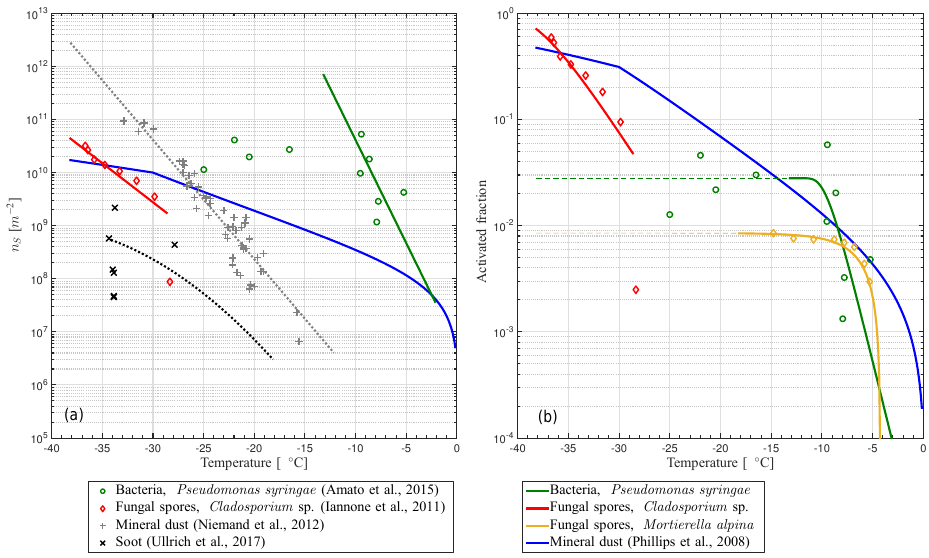
Figure 1. (a) INAS density n S and (b) ice-active fraction f IN versus temperature T for PB-INPs ( Pseudomonas syringae bacteria, Cladospo- rium sp., and Mortierella alpina fungal spores; r N of Table 1 used here) as well as mineral dust (Phillips et al., 2008, assuming a particle size of r N = 3 . 45 × 10 − 6 ) and soot (Ullrich et al., 2016) used in this